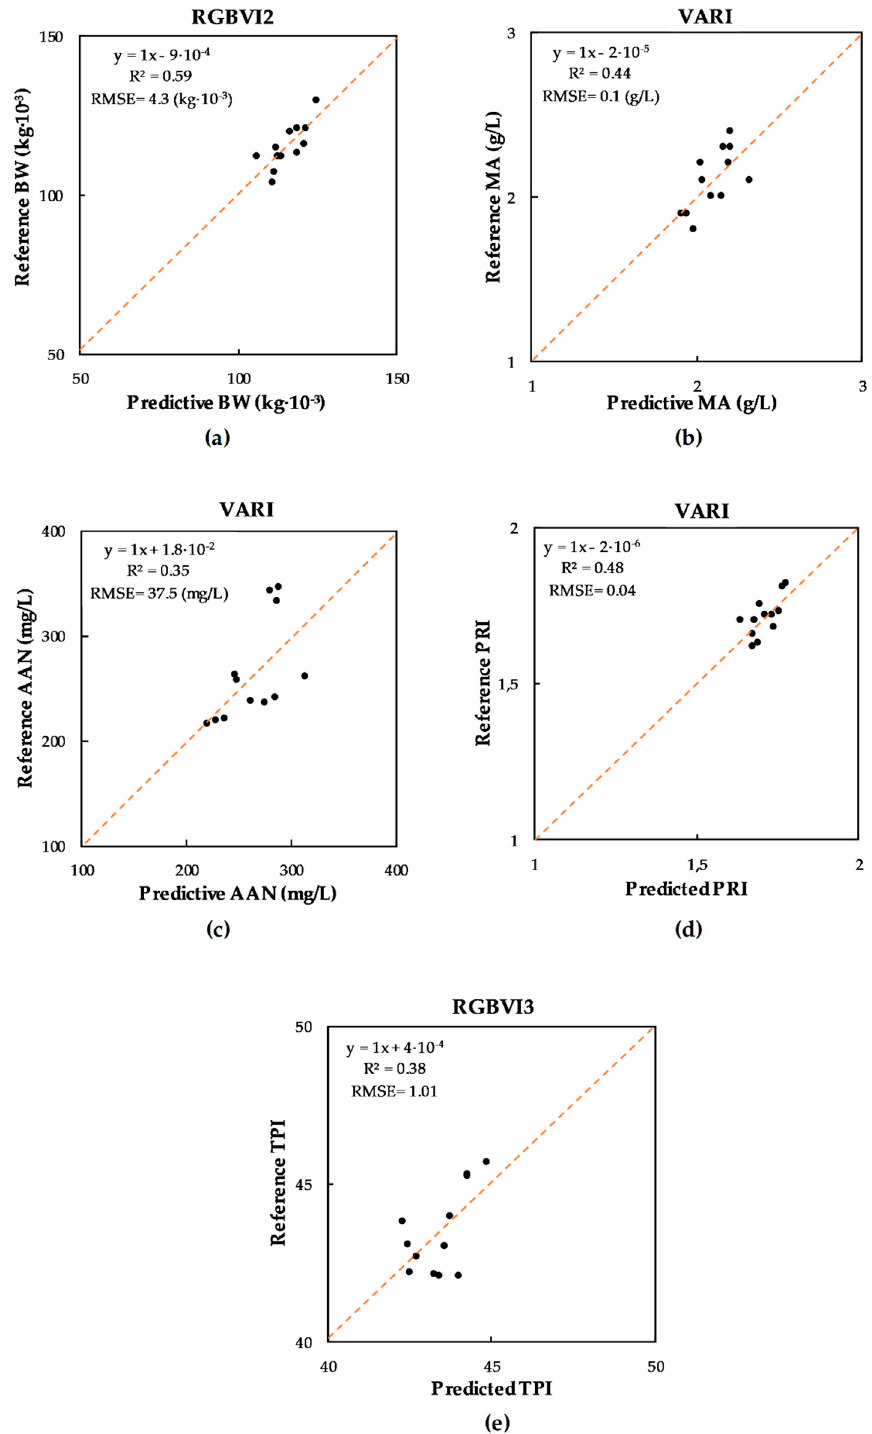
Figure 5. Linear relationship between must properties as measured by laboratory analysis and as predicted by the vegetation indices. ( a ) BW and RGBVI2. ( b ) MA and VARI. ( c ) AAN and VARI. ( d ) PRI and VARI. ( e ) TPI and RGBVI3. BW: 100-berry weight (kg · 10 − 3 ); MA: malic acid (g/L); AAN: alpha amino nitrogen (mg/L); PRI: phenolic ripeness index; and TPI: total phenolic index. The 1:1 line is indicated in each figure.